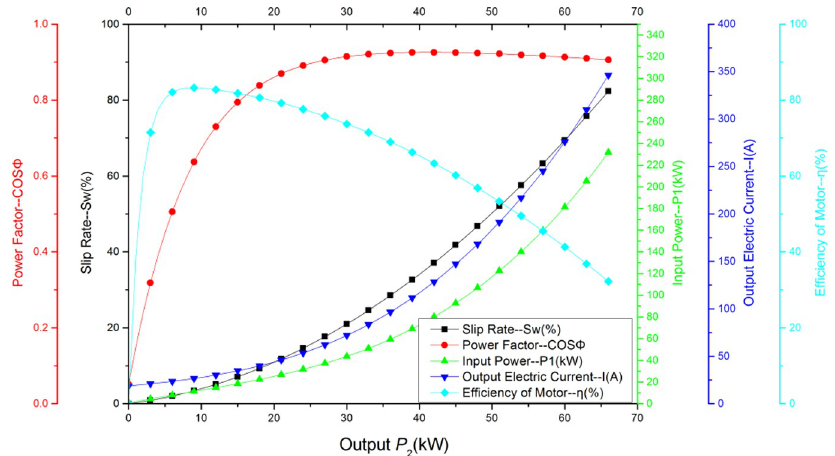
Fig 2. YCCH225-6 drive motor operating